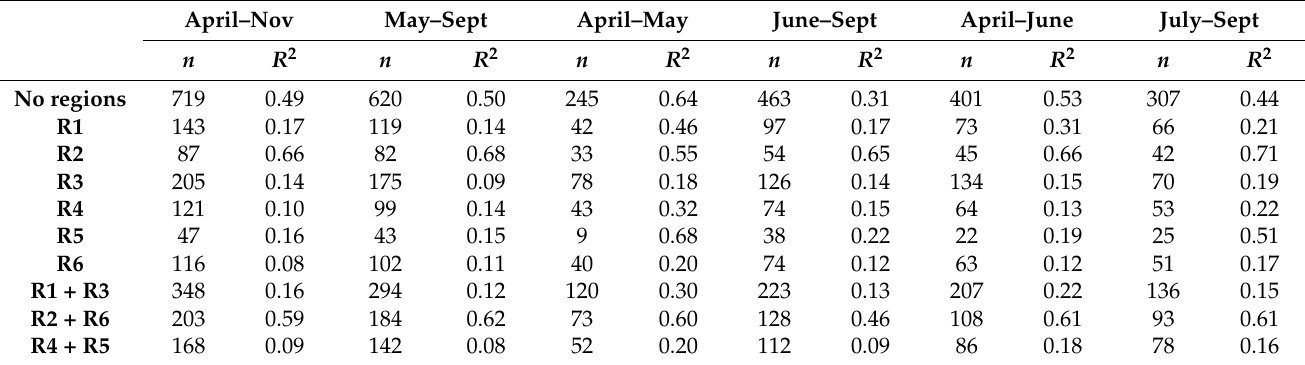
Table 6. The number of match-ups ( n ) and the determination coefficients ( R 2 ) of the quadratic polynomial regression model for the best algorithm out of 25,013 for different regions (R1–R6)